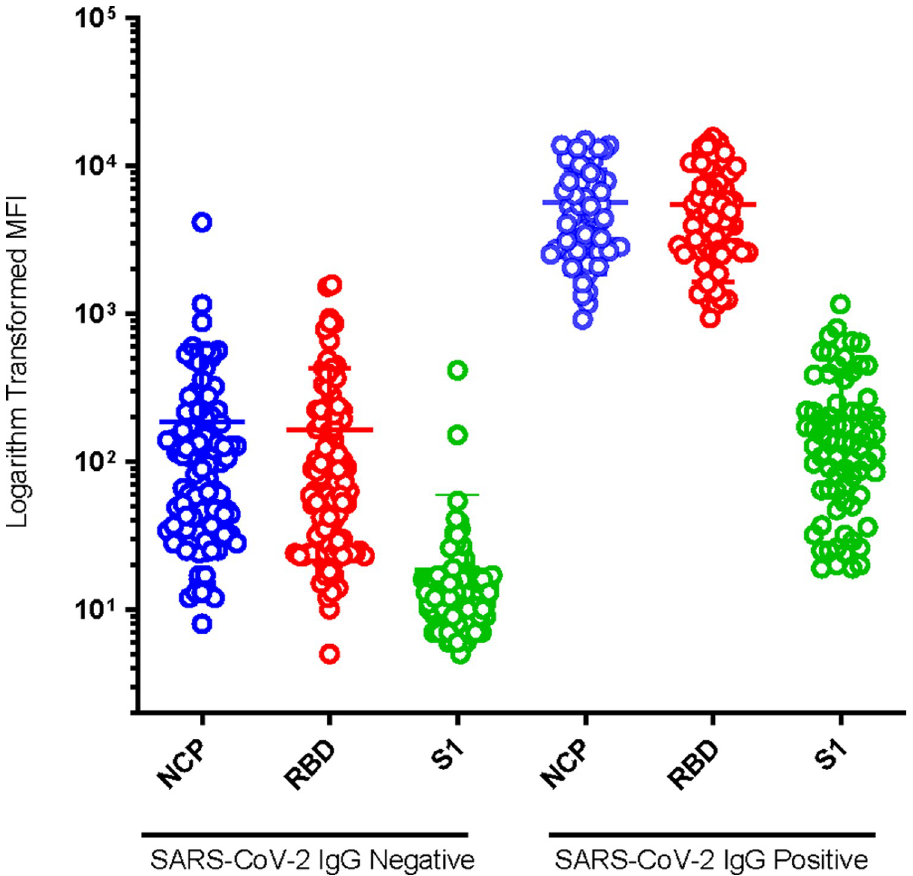
Fig 1. Dot plot indicating logarithmic transformed MFI levels of antibody responses to SARS-CoV-2 IgG negative and positive specimens of the 2018 NAIIS pre-pandemic samples, Nigeria, 2021. NCP = nucleocapsid, RBD = receptor-binding domain, S1 =